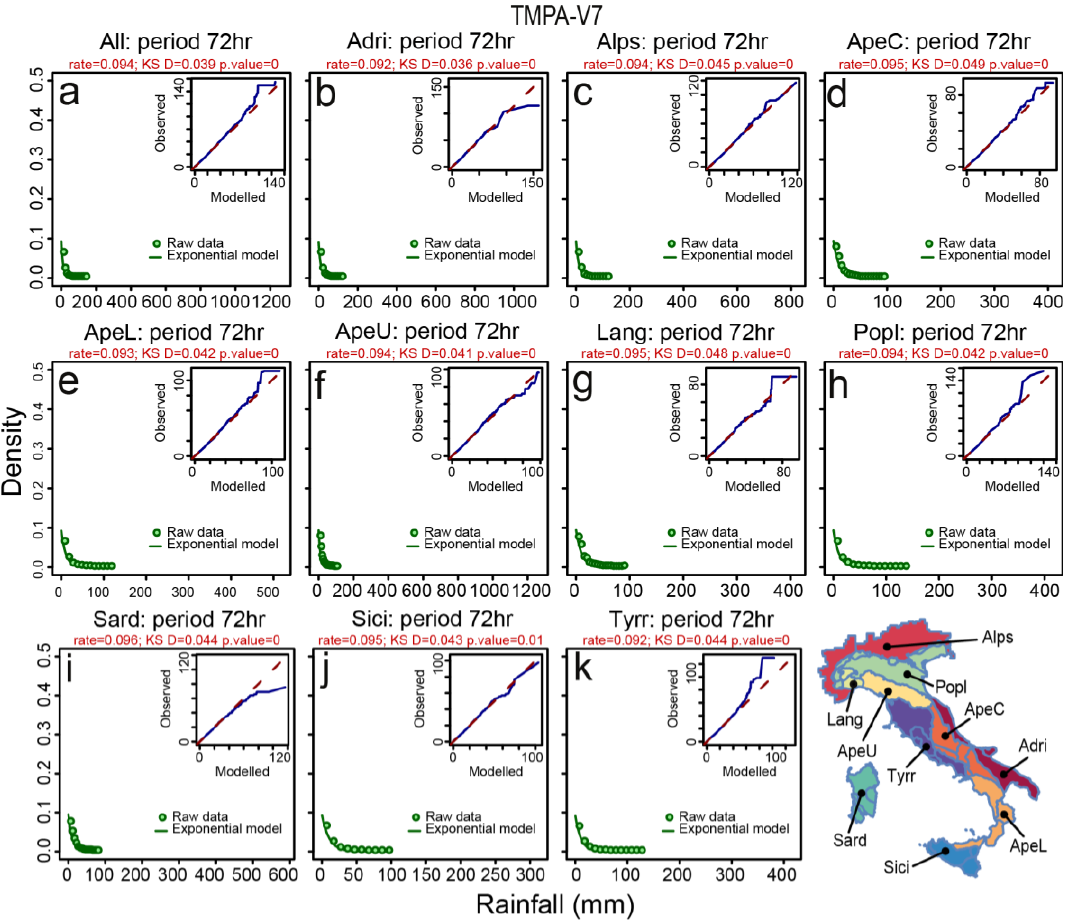
Figure 14. Exponential distribution estimated for 72-h cumulative rainfall using the MLE method for satellite estimates (TMPA-V7). The different plots show results for different Italian morphological subdivisions: ( a ) entire Italian territory; ( b ) Adri; ( c ) Alps; ( d ) ApeC; ( e ) ApeL; ( f ) ApeU; ( g ) Lang; ( h ) Popl; ( i ) Sard; ( j ) Sici; ( k ) Tyrr. The insets show QQ-plot measuring the fitting performance of the exponential model. KS D and p -value are two-sided bootstrapped Kolmogorov-Smirnov test statistics (see Table 6).